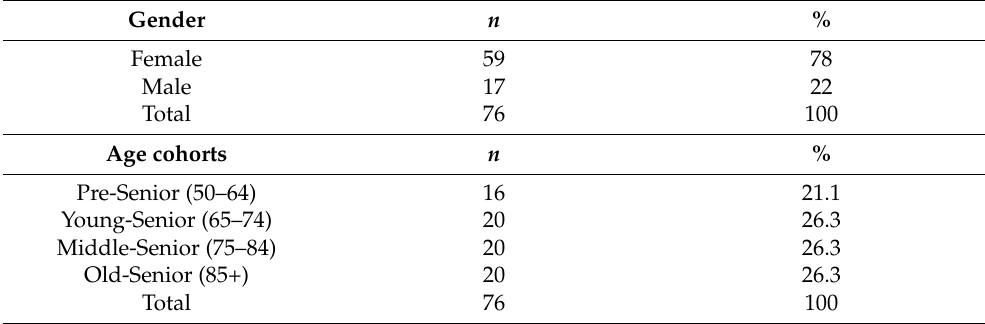
Table 3. Demographic characterization of the